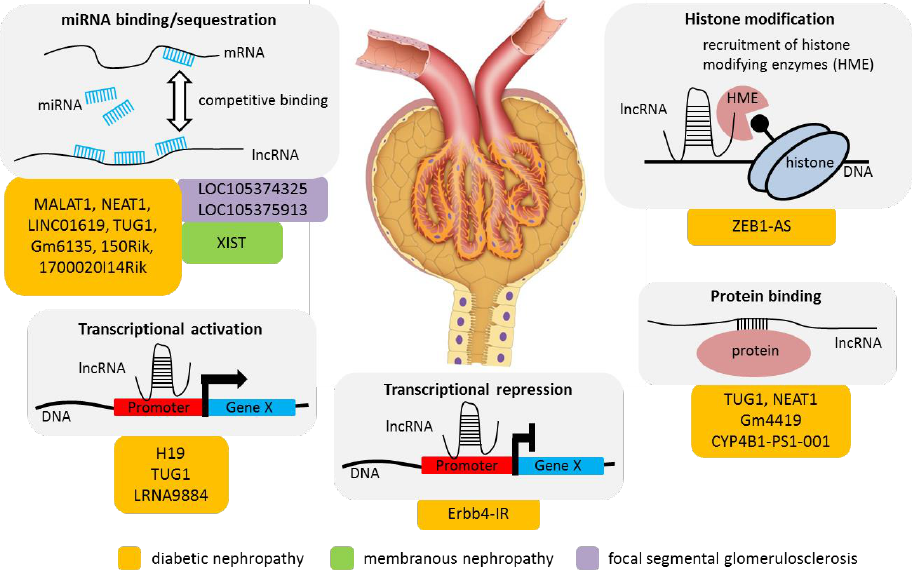
Figure 1. Long non-coding RNAs (lncRNAs) in glomerular disease and their reported molecular functions. Grey colored boxes depict the molecular mechanisms of lncRNA function (enhancer RNA, transcriptional repression, transcription activation, protein binding, miRNA binding/sequestration and histone modification) reported to play a role in glomerular disease. Orange, green and purple colored boxes indicate the disease: diabetic nephropathy, membranous nephropathy and focal segmental glomerulosclerosis, respectively. The lncRNAs associated with the particular mechanism and disease are specified by name. Glomerulus image obtained from: Aldona Griskieviciene /